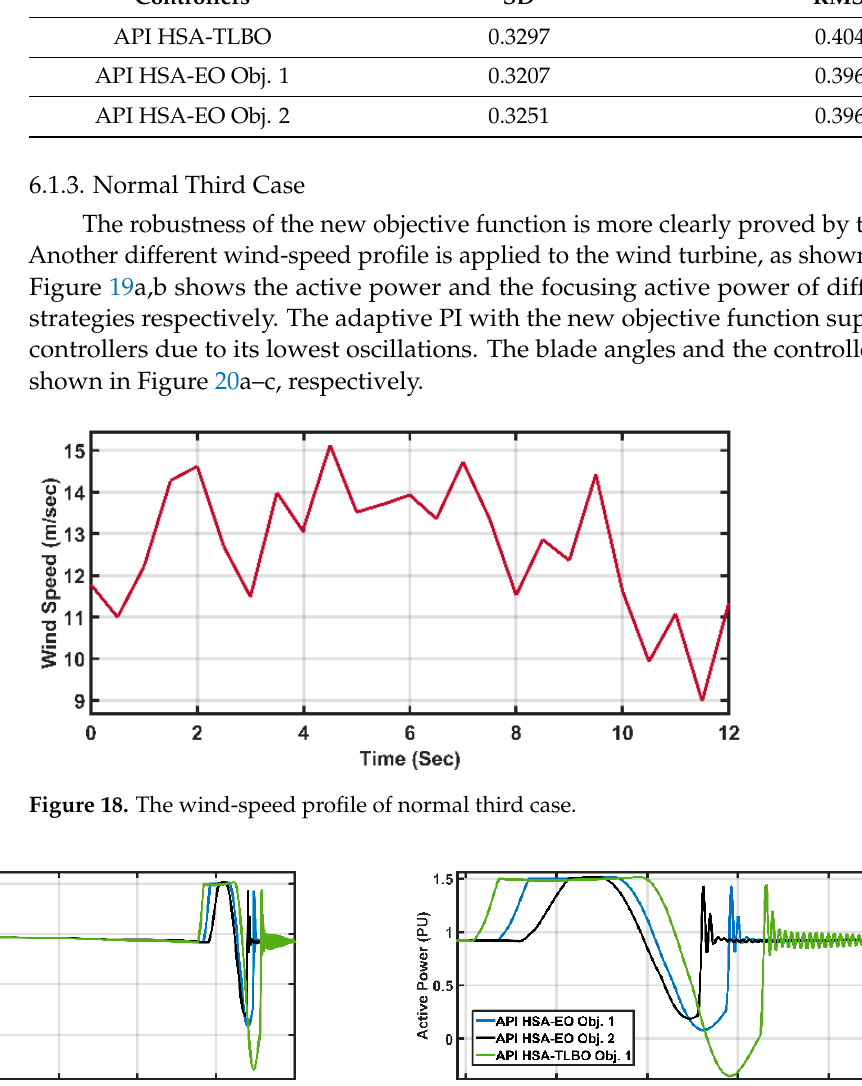
Table 5. Statistical analysis of the active power—normal second case.